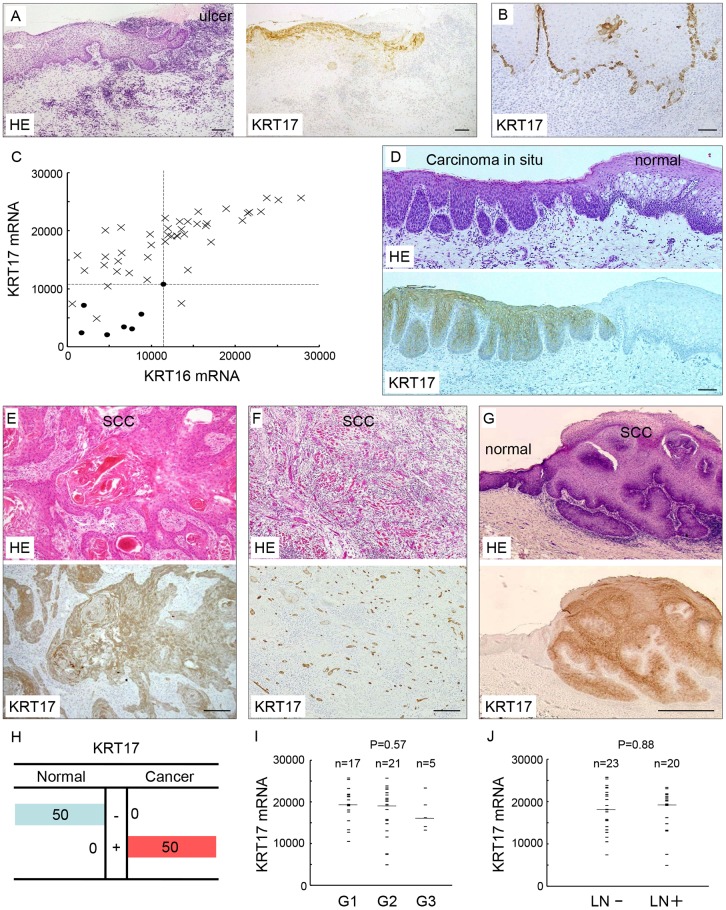
KRT17 expression was induced in the regenerative epithelium and oral squamous cell carcinoma (OSCC).(A) KRT17 expression in regenerative epithelium. Hematoxylin and eosin (HE) staining (left panel) and immunohistochemical staining using the anti-KRT17 antibody (right panel). KRT17 expression was induced in the regenerative epithelium at the edge of the traumatic ulcer of the oral mucosa. Scale bar, 100 μm. (B) KRT17 expression in hyperplastic epithelium. Immunohistochemical staining using the anti-KRT17 antibody. In this buccal mucosa with nonspecific inflammation, KRT17 expression was induced in the basal cells. Note the scattered distribution of KRT17-positive cells in the basal layer. Scale bar, 100 μm. (C) cDNA microarray analysis of KRT16 and KRT17 in 43 OSCCs and 7 normal oral epithelia. The scales on the horizontal and vertical axes represent absolute signal values. Crosses denote each OSCC case and filled circles denote normal controls. The dashed lines were placed at the maximum values in the normal epithelium. (D-G) Immunohistochemical expression of KRT17 in OSCC. (D) KRT17 was expressed in the carcinoma in situ (left side), whereas KRT17 was not expressed in the normal epithelium (right side). Scale bar, 100 μm. (E, F, G) HE staining (upper panels) and immunohistochemical staining using the anti-KRT17 antibody (lower panels) in OSCC specimens. The upper and lower panels are serial sections from one sample. KRT17 expression was constantly induced in OSCC regardless of the histology. The levels and distributions of expression showed little variation across cases. Scale bar, 100 μm. (E) Keratinizing tumor nests and (F) small tumor islands of OSCC, both showing similar levels of ubiquitous KRT17 expression. Scale bars, 200 μm (E) and 100 μm (F). (G) Condylomatous tumor that showed highly differentiated histology was also positive for KRT17. Normal epithelium was present at the left side, showing negative staining. Scale bar, 1 mm. (H) Summary of immunohistological KRT17 expression in 50 OSCC cases. +, strong staining; -, weak or no staining. (I) Comparison between KRT17 expression and histological grade of differentiation in 43 OSCCs. G1, well differentiated; G2, moderately differentiated; G3, poorly differentiated. Bars depict the median. N is the total number of cases analyzed. (J) Comparison between the KRT17 expression and presence of lymph node metastasis in 43 OSCCs. Bars depict the median. N is the total number of cases analyzed.